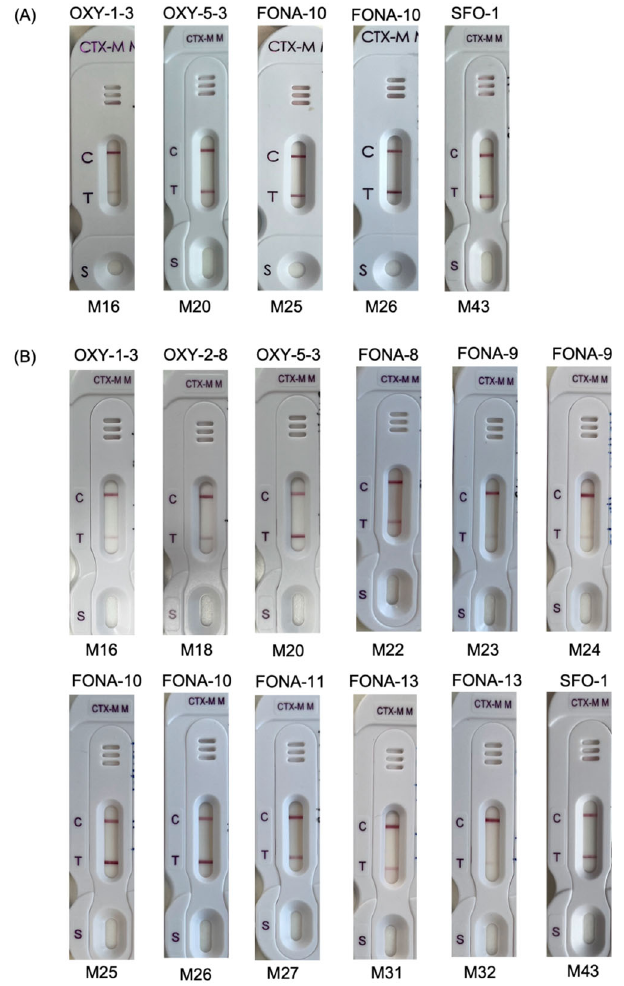
Figure 2. NG-Test CTX-M MULTI results obtained for ( A ) positive blood culture spikes with 5 isolates expressing CTX-M-like β -lactamase; ( B ) bacterial colonies of 12 isolates expressing CTX-M-like β -lactamase. The labels above and below each photo show the β -lactamase name and sample name, respectively.